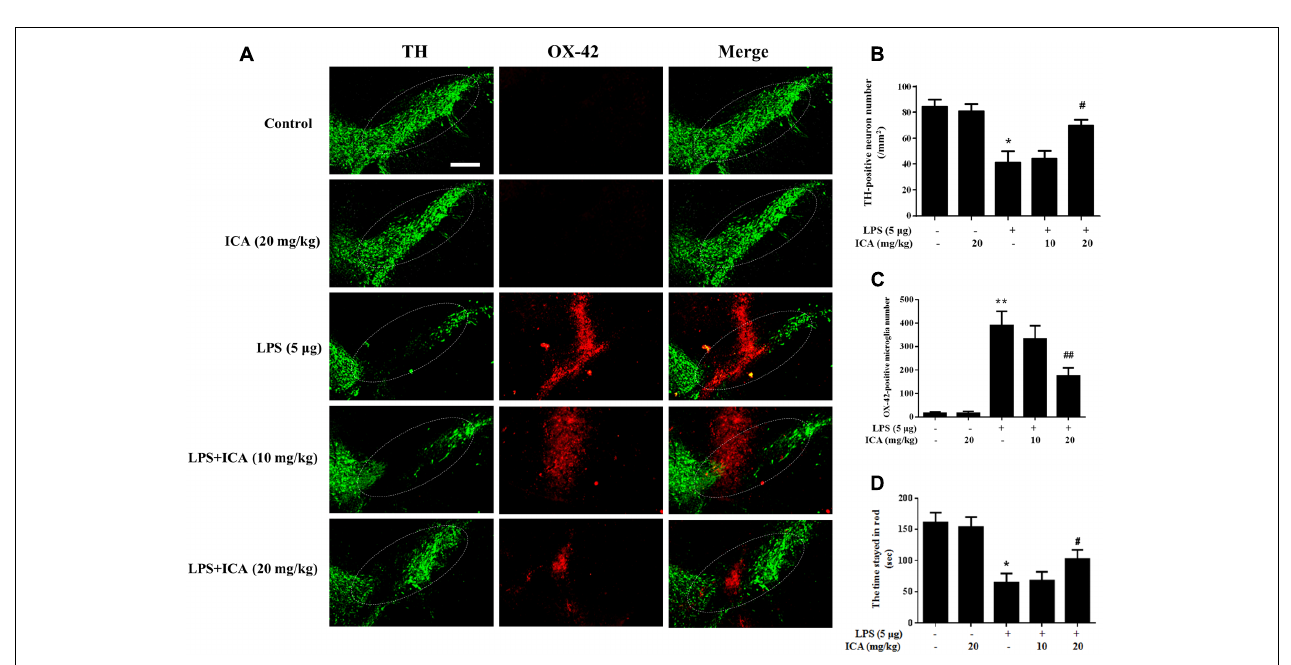
FIGURE 7 | Icariin attenuated LPS-Induced DA neuronal loss and microglial activation in vivo . Rats were given a single intranigral injection of LPS into the SN pars compacta on one side of rat brain followed by daily intragastric administration of ICA for 7 consecutive days. Then, rats were sacrificed and the brains were collected. Double-label immunofluorescence was performed by staining with anti-TH and anti-OX-42 antibodies (green fluorescence represented DA neurons and red fluorescence represented microglia) (A) . The “ellipse” presented the area of SN. Scale bar: 200 µ m. The number of SN TH-positive neurons (mm 2 ) was counted (B) and the quantification of SN OX-42-positive microglia number was performed (C) . Rat behavior changes were analyzed through rotarod test. The time stayed in rod was recorded (D) . Results were the mean ± SEM from six rats ( n = 6). ∗ p < 0.05 or ∗∗ p < 0.01 compared with the control group; # p < 0.05 or ## p < 0.01 compared with LPS-treated